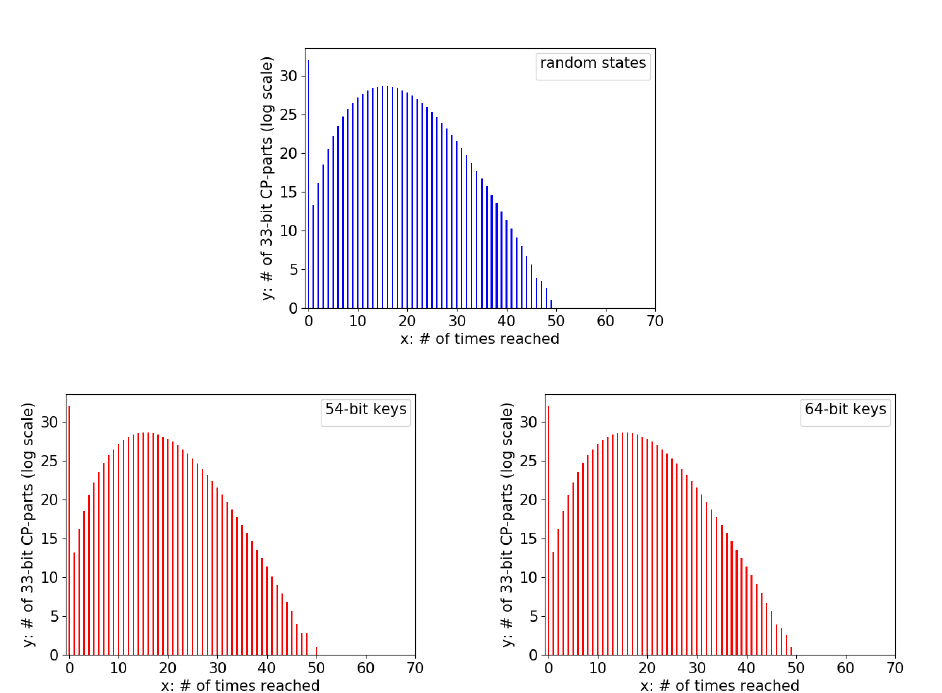
Figure 2: One diagram represents the number of 33-bit CP part values (in log scale) from experimental data in ordinates that are reached exactly x times on the horizontal axe. The experimental data for the two red diagrams are generated as described in Algorithm 2 with 54-bit keys for the left one and 64-bit keys for the right one. The experimental data of the blue diagram comes from directly randomly generating the 33-bit CP part of the A5/1 internal